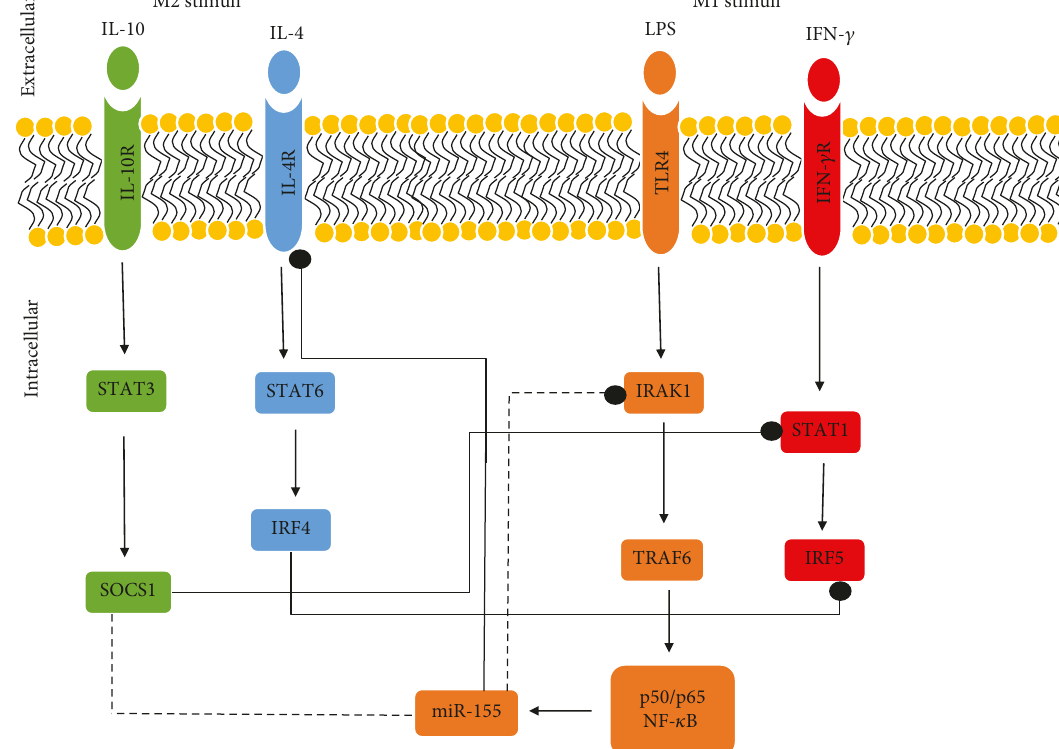
Figure 2: The polarisation of M1 and M2 macrophages from monocytes in the presence of their microenvironmental cues. The arrows indicate the e ff ect from positive regulation (induction or activation), bullet-end lines indicate the e ff ect from negative regulation (inhibition/inactivation), and the dotted lines indicate direct targets of the miRNA (adapted and modi fi ed from Mantovani and Locati [32]).